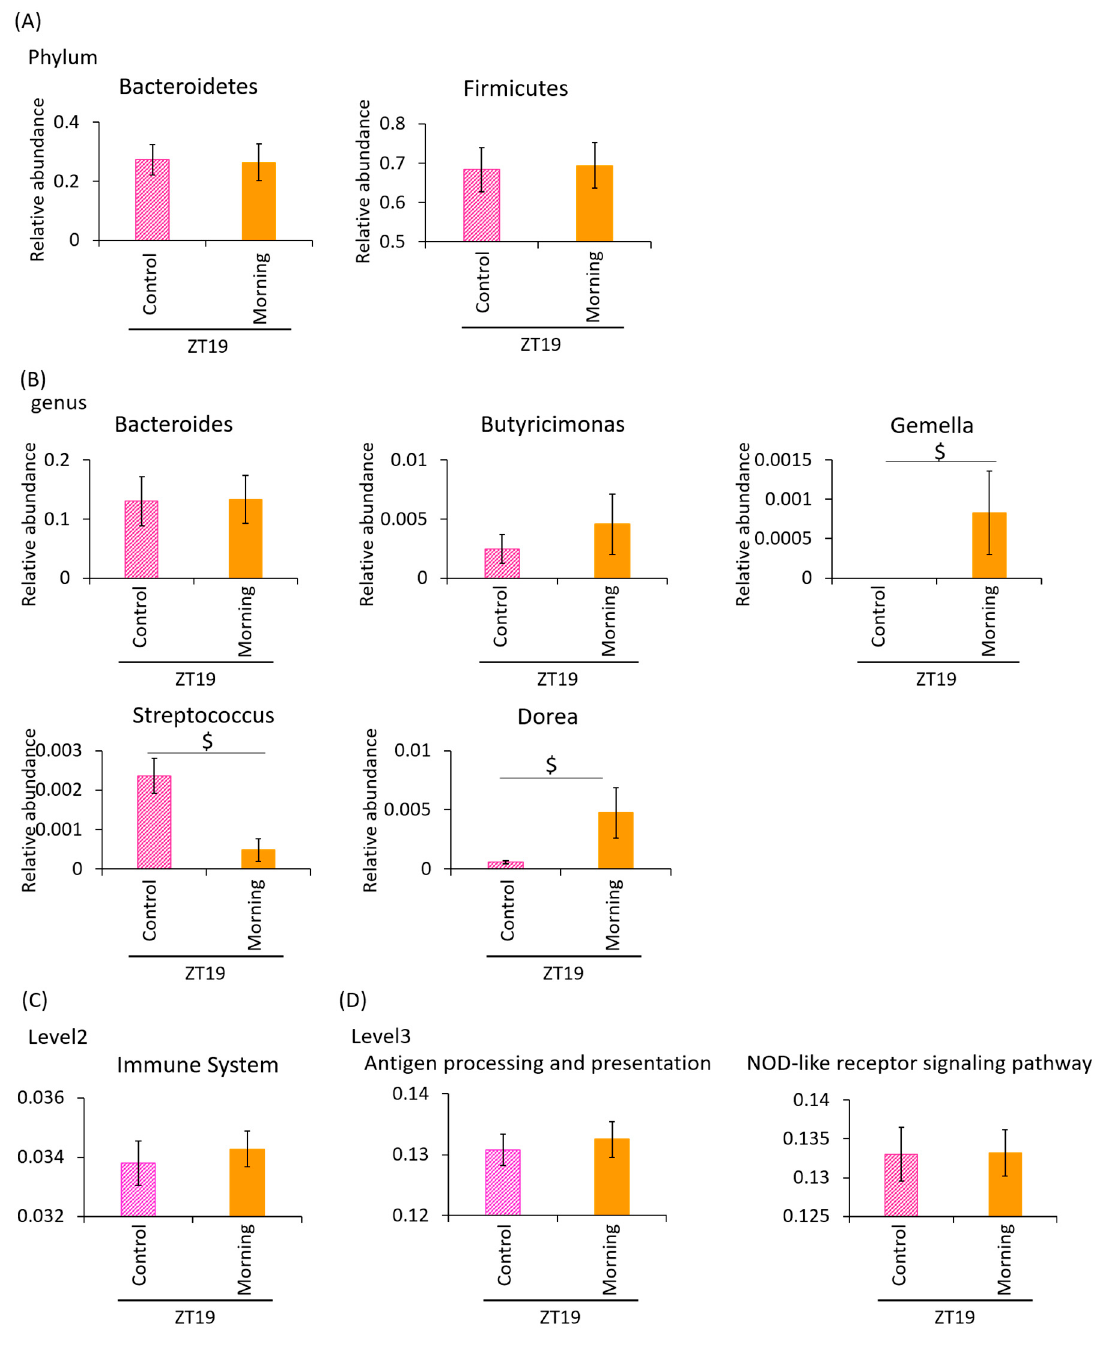
Figure 7. Effect of small-volume intake of A. lappa in the morning on the relative abundance of some bacteria and prediction of function by PICRUSt analysis. ( A ) The relative abundance of phylum level, ( B ) genus level in each group, ( C ) PICRUSt analysis of immune system, and ( D ) antigen processing and presentation and the NOD-like receptor signaling pathway. All data are represented as mean ± SEM ( n = 5 for each group). p < 0.05 evaluated using the t-test. The morning group took A. lappa during ZT12–ZT15 and was sacrificed at ZT19.